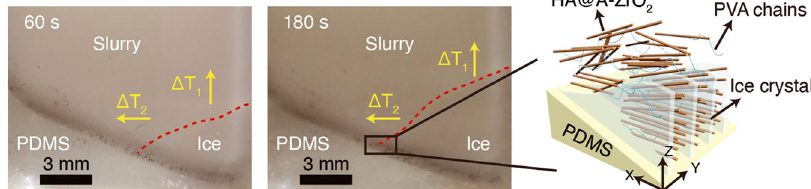
Fig. 1 Assembly of the nanorod structure. A temperature gradient is induced by a PDMS wedge-shaped surface, which causes a temperature gradient within the nanorod-dispersion on top. Solvent ice crystals form in parallel lamellae when the temperature sinks. The hydroxyapatite nanorods coated